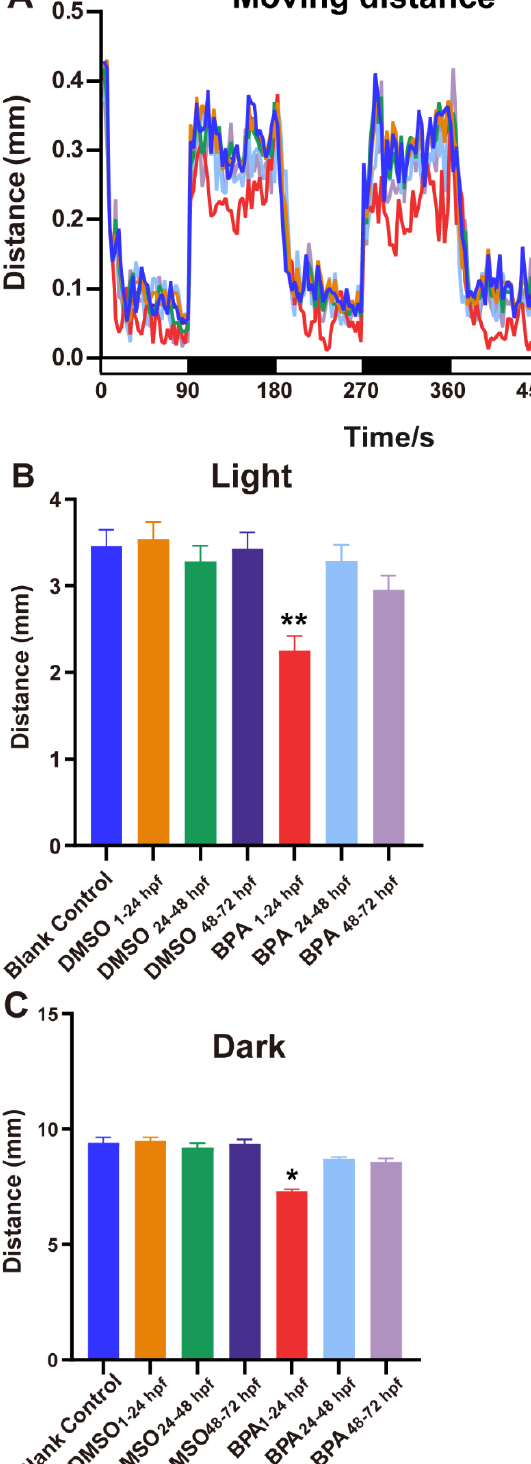
Figure 4. Effects of exposure to BPA on locomotor behavior under the light-dark cycle stimulation of zebrafish embryos at different developmental periods. ( A ) The trend of distance. ( B , C ) The analysis results of the trend of the distance. Abscissa white for light, black for darkness. Data are the mean ± SD (n = 24 in each concentration). *, significant from blank control, p < 0.05, **, significant from blank control, p < 0.01.